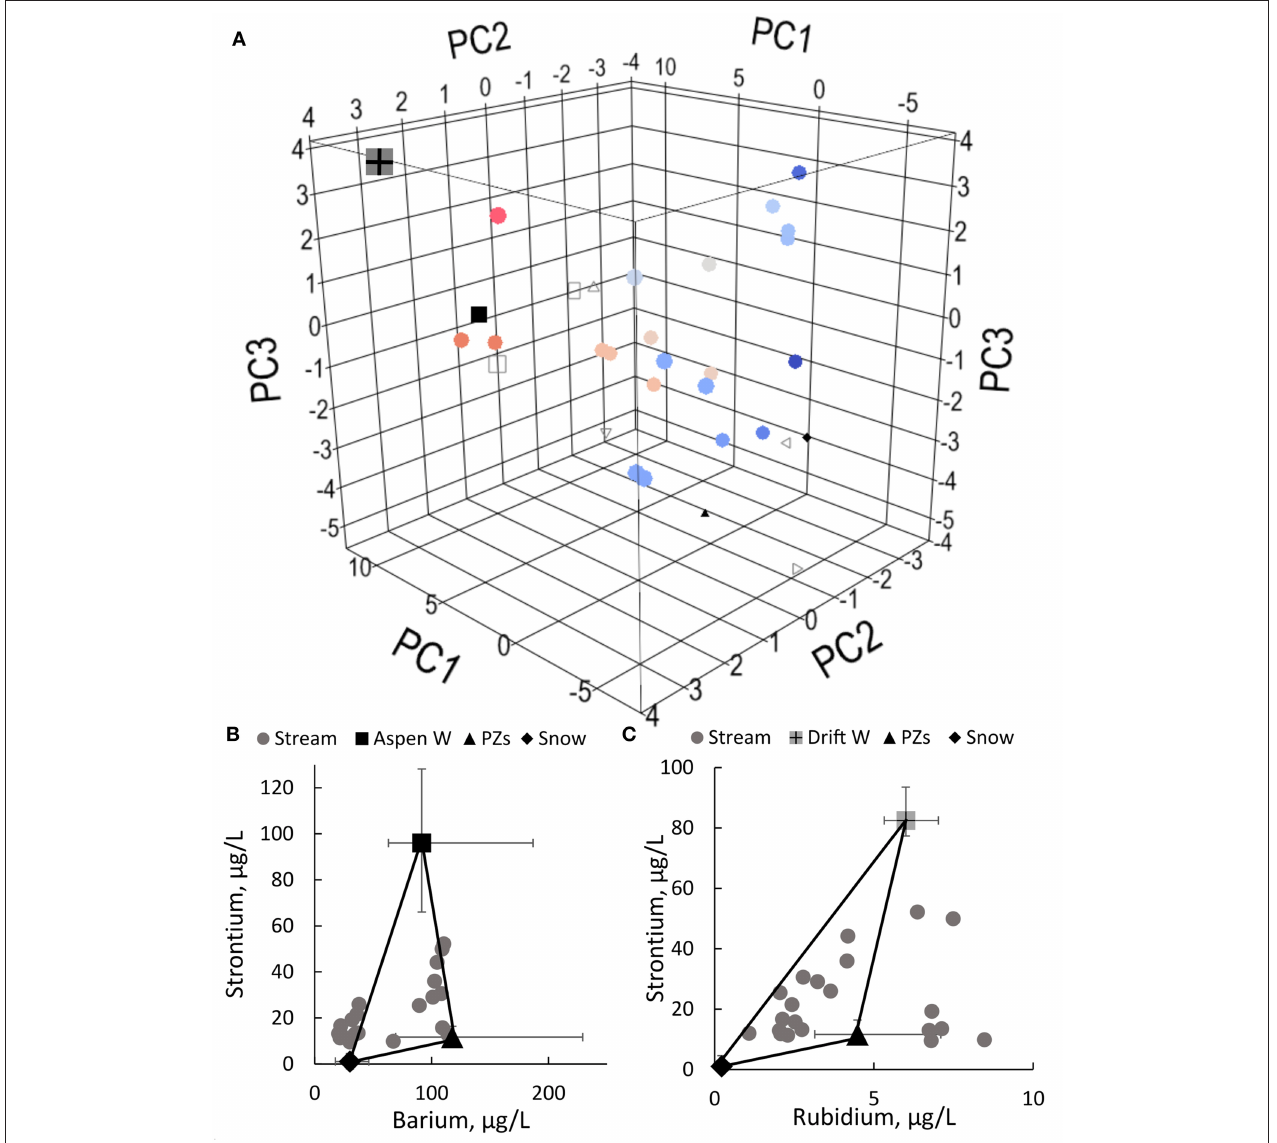
FIGURE 4 | End-member mixing analysis shown in: (A) 3D concentration space, (B) the Ba-Sr plane of concentration space, and (C) the Rb-Sr plane of concentration space. Error bars on end-member median concentrations represent the interquartile range (IQR) of concentration distributions for each end-member, and are not shown if smaller than markers. Stream samples (filled circles) in panel (A) progress in color from blue to red with sample date from March to October 2017. Note that points that fall outside the represented polygon (as in C ) are still within the concentration range of each end-member (maximum Rb concentrations for PZs and Drift W, 10.3 and 13.8 ppb, respectively). To solve for the fractional contribution, those points are projected onto the closest plane and values are assumed to be a fractional mix of the end-members comprising that plane (adaptation of the 2D method applied by Liu et al., 2004). See section Results for further discussion of this